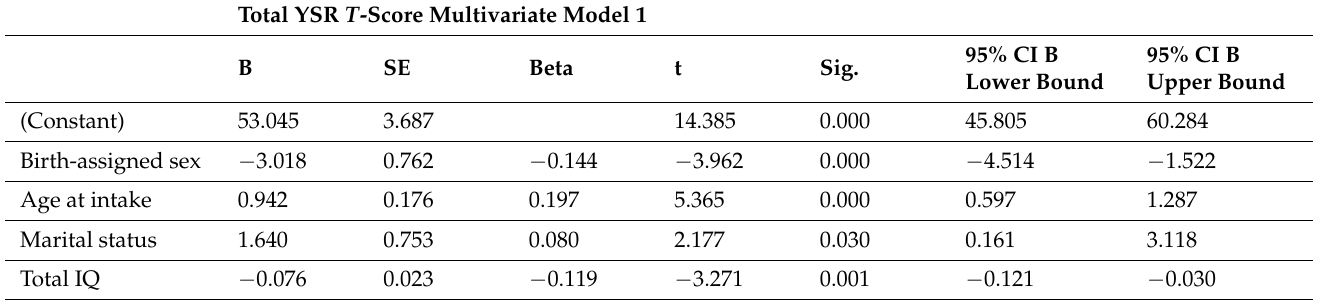
Table 4. Multiple linear regression for BIS total scale and YSR T